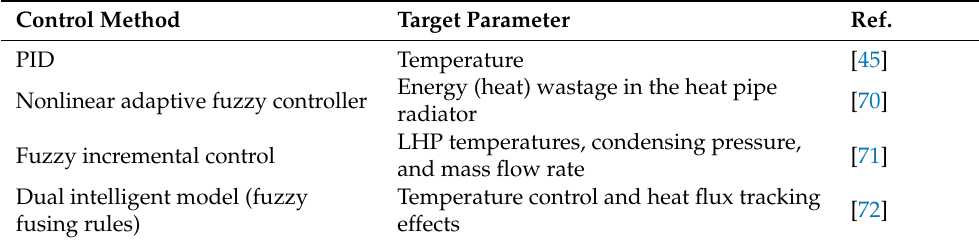
Table 2. Intelligent control methods for heat